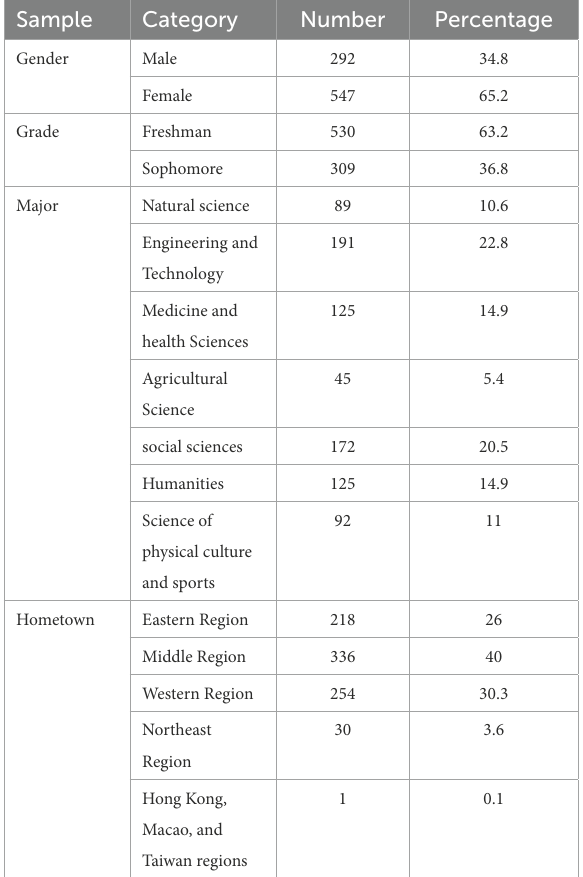
TABLE 2 Basic information of interviewees.